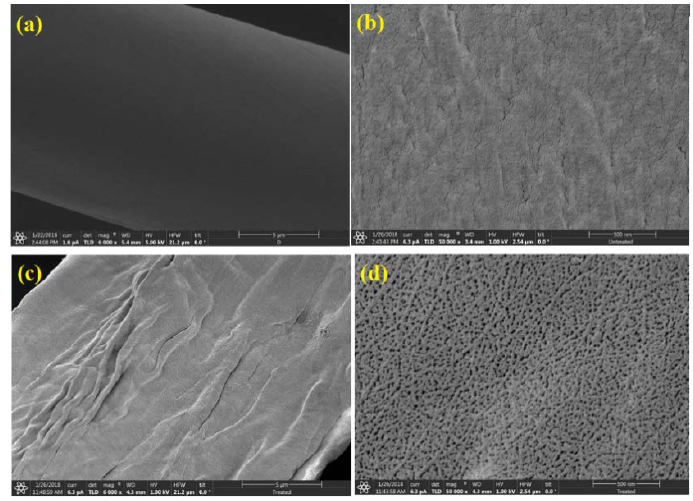
Figure 3. SEM images of ( a , b ) untreated C. pentandra fiber and ( c , d ) treated C. pentandra fiber at 6000 × and 50,000 × magnification, respectively.